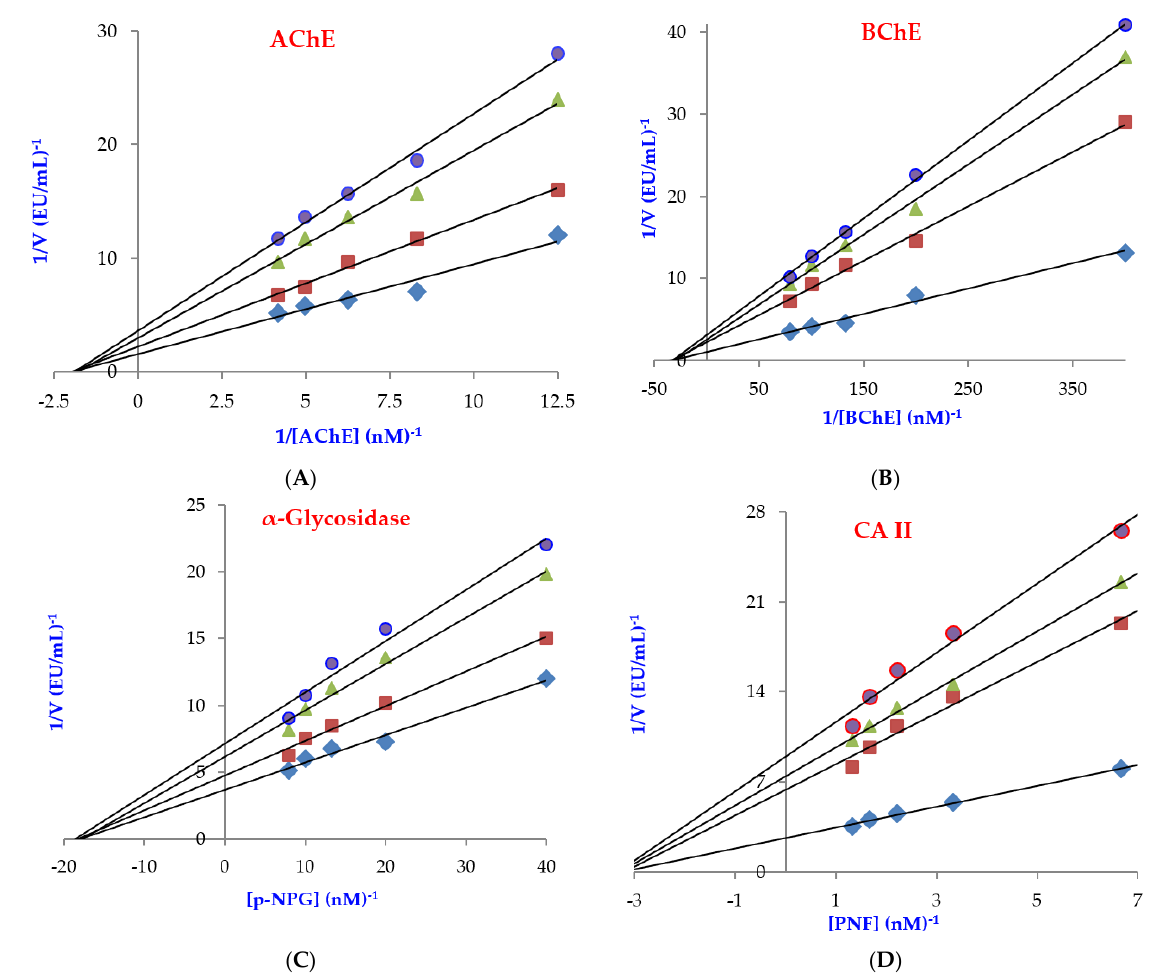
Figure 5. Lineweaver–Burk graphs of Coumestrol against acetylcholinesterase (AChE) ( A ), butyrylcholinesterase (BChE) ( B ), α‐ glycosidase ( C ), and carbonic anhydrase II (CA II) ( D ).